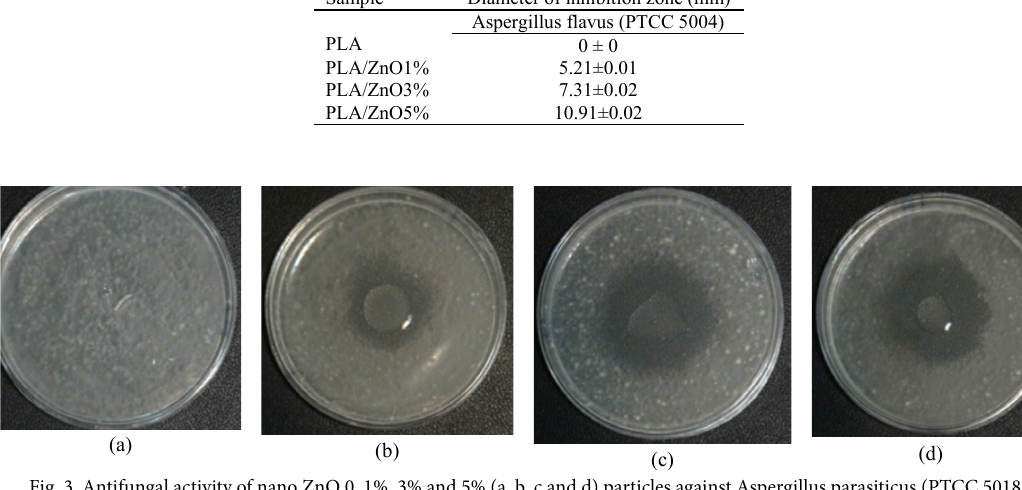
Fig. 3. Antifungal activity of nano ZnO 0, 1%, 3% and 5% (a, b, c and d) particles against Aspergillus parasiticus (PTCC